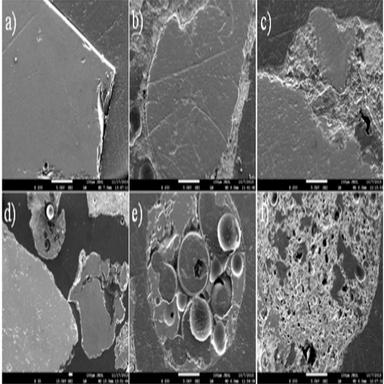
Typical morphology of polished IBA particles observed under SEM.